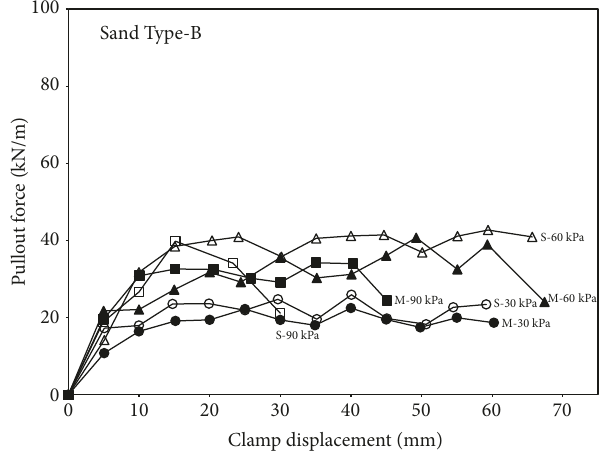
Figure 8: Front pullout displacement relative to pullout force with confining stress using Type-A.